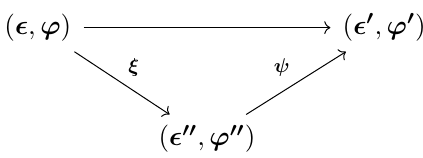
Figure 22 . Field configuration ( (cid:15) 0 , ϕ 0 ) is obtained from ( (cid:15) , ϕ ) by a vertex transformation ξ followed by an edge transformation ψ